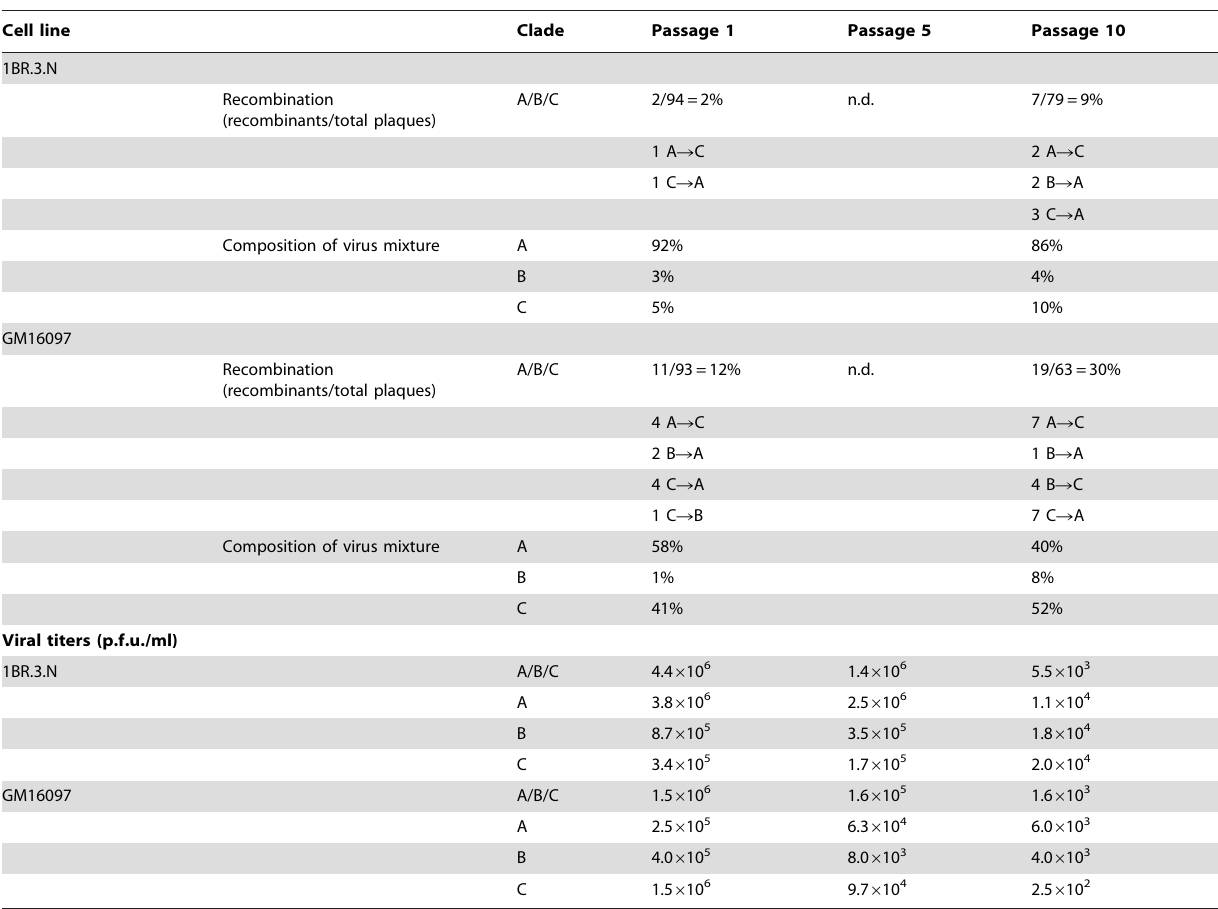
Table 2. Recombination during serial passage of